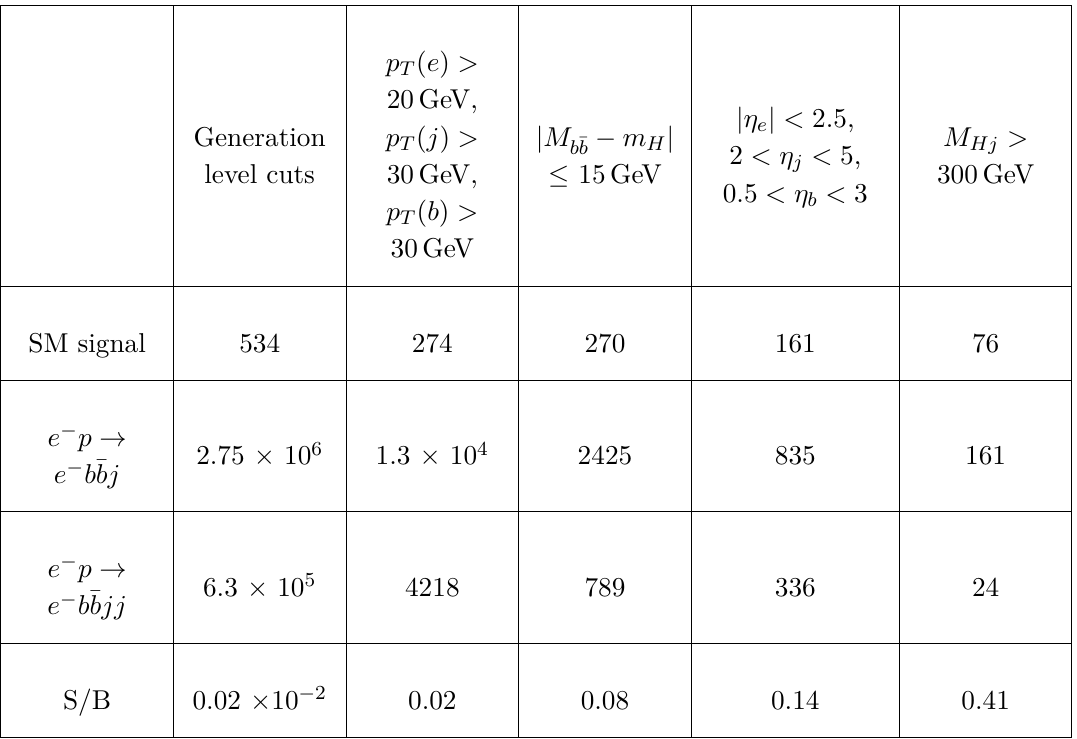
Table 2 . SM signal and background events (at L = 100 fb − 1 ) with selection cuts for the NC process. Signal to background ratio (S/B) is given in the last row. We have assumed b tagging efficiency of 60%. For -80% polarized electron, the S/B ratio changes to 0.3.